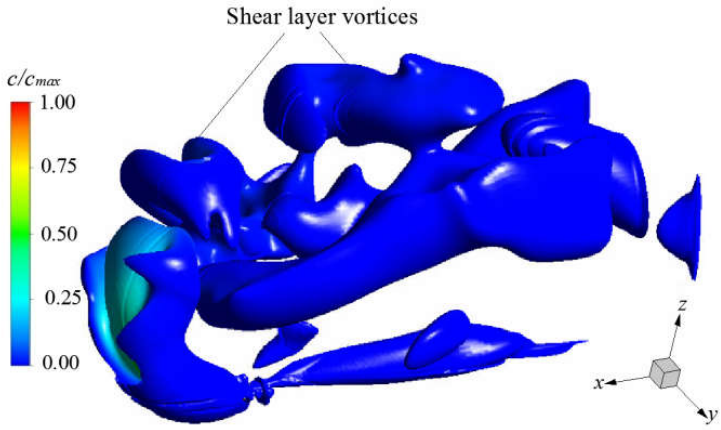
Figure 6. Isosurfaces of vortex-identification criterion Q = 0.11 s −2 based on the velocity field colored by normalized concentration on grid 1.